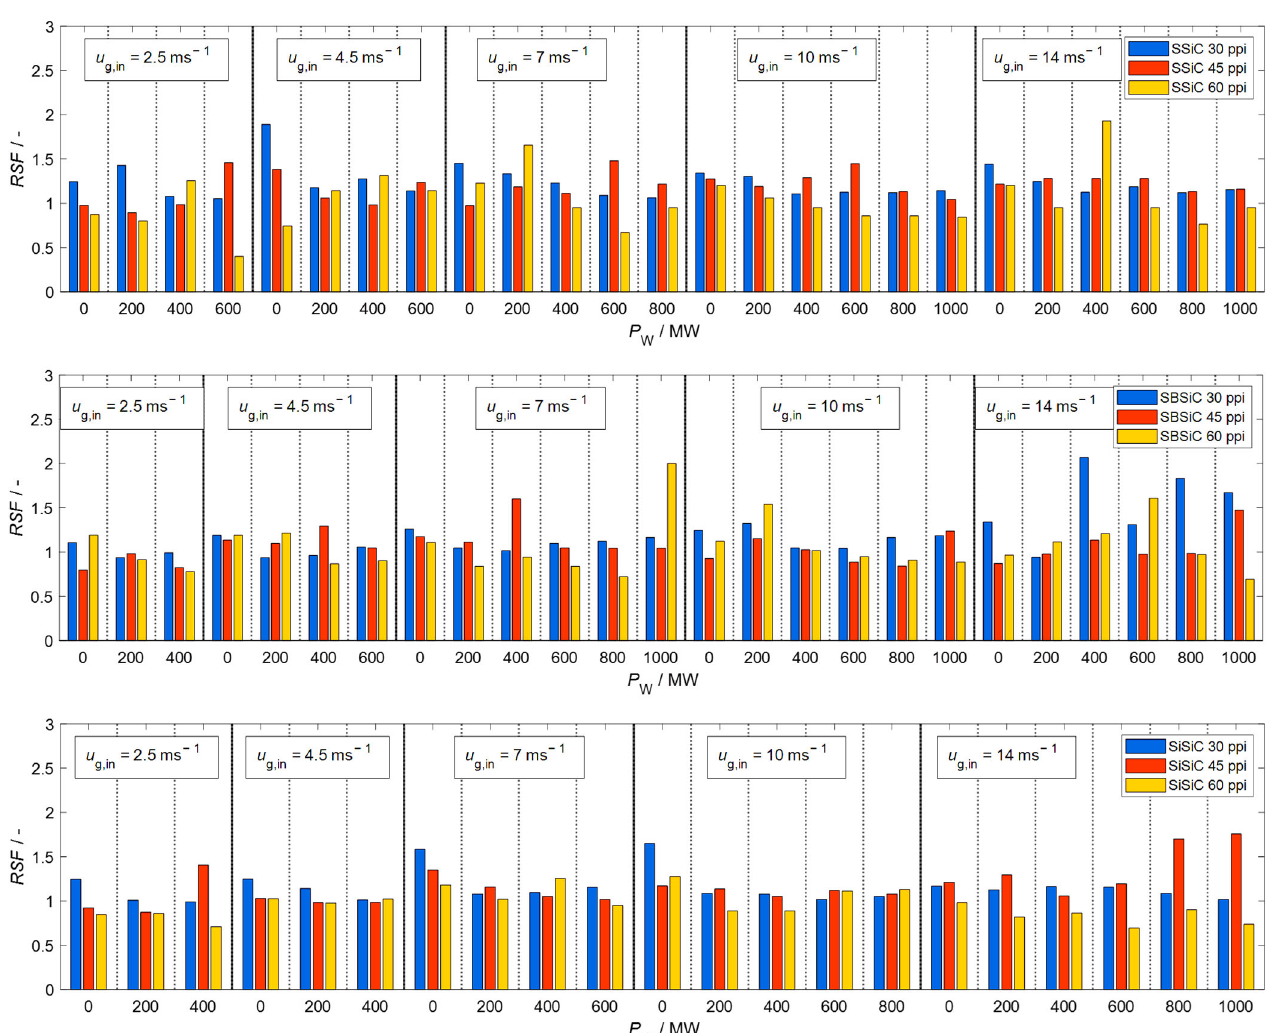
Figure 10. Diameters 𝑑 (cid:2869)(cid:2868) (black symbols) and 𝑑 (cid:2906)(cid:2868)(cid:2877) (red symbols) of droplets crossing the outlet position of the microwave applicator loaded with SBSiC ( top ), SSiC ( middle ) and SiSiC ( bottom ) foams at an input magnetron power up to 1 kW.